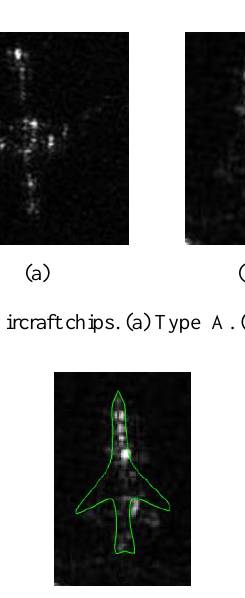
Figure 2. The limitation of ASM based on PCA.